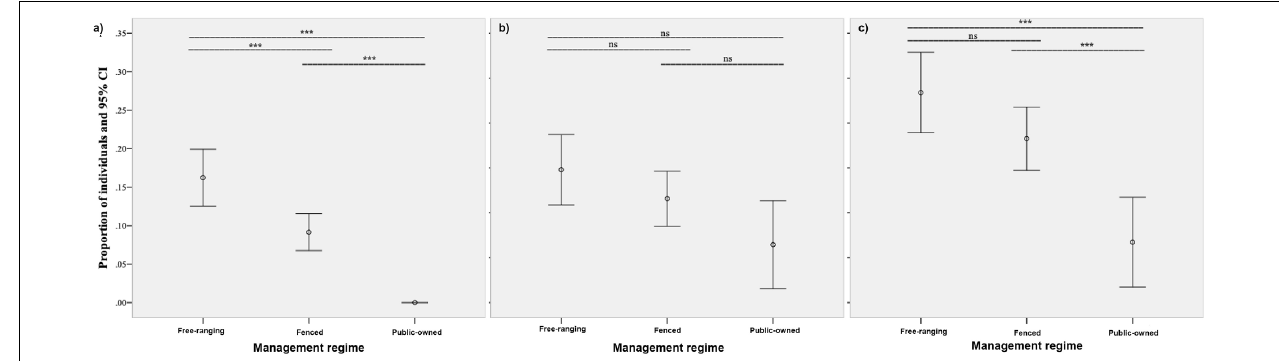
FIGURE 7 | Proportions of individuals with signs of mitochondrial introgression (a) , nuclear DNA admixture and non-native individuals (b) , and both introgressed and non-native/hybrid individuals (c) . The significance of two-pairwise comparisons between hunting management regimes is also shown (***significant at p -value < 0.05; ns,